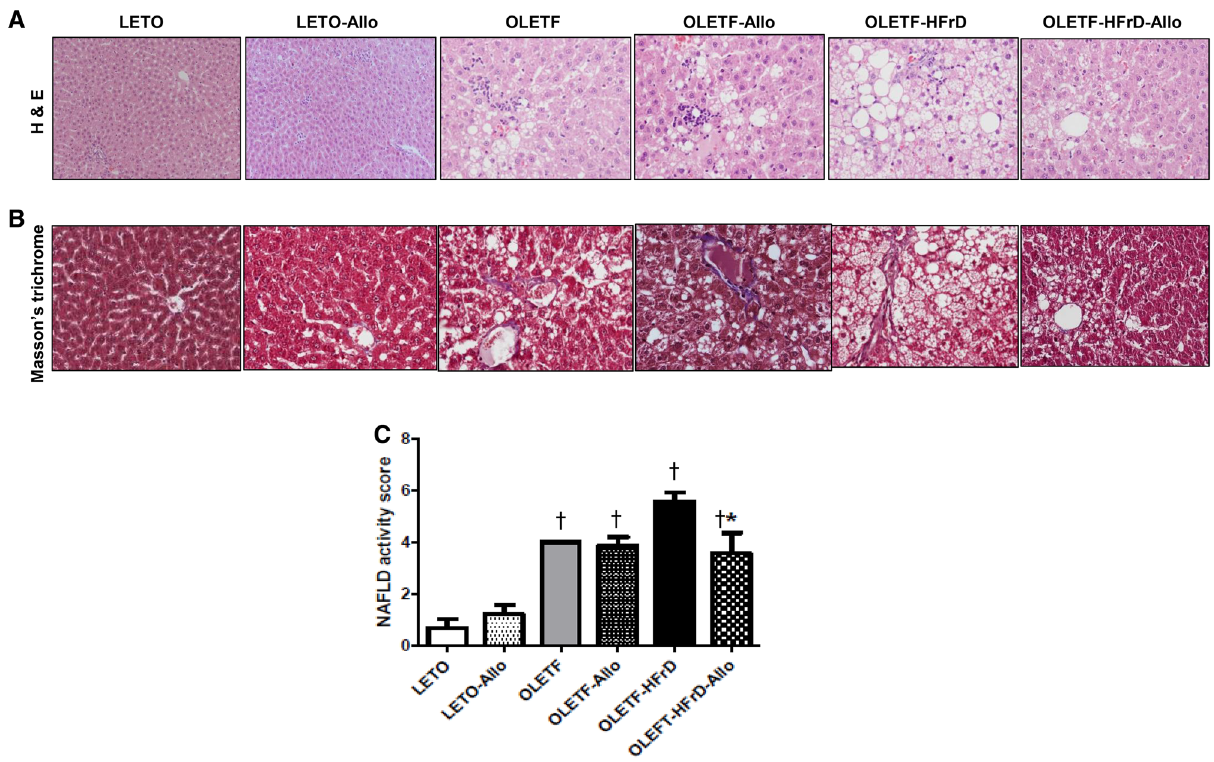
Figure 2. Liver pathology and NAFLD activity score after 16 weeks of LETO, OLETF, and HFrD-fed OLETF rats with or without allopurinol treatment. Liver morphology was visualized and evaluated using light microscopy (400 × magnification) on tissue sections subjected to hematoxylin and eosin (H&E) and Masson’s trichrome stains. ( A ). H&E-stained sections from rats in the OLETF and OLETF-HFrD group showed significant hepatic lipid accumulation compared to LETO group. Hepatic steatosis was decreased in the OLETF- HFrD-Allo group. ( B ). Significant fibrotic changes were not observed in all experimental groups. ( C ). NAFLD activity score was significantly elevated in the OLETF and OLETF-HFrD group compared to LETO group. Also, it was significantly decreased in OLETF-HFrD-Allo group, compared to OLETF-HFrD group. † P < 0.05 versus LETO group. * P < 0.05 versus OLETF-HFrD group. LETO, Long-Evans Tohushima Otsuka; LETO-Allo, LETO rats treated with allopurinol; OLETF, Otsuka Long-Evans Tokushima Fatty rats; OLETF-Allo, OLETF rats treated with allopurinol; OLETF-HFrD, OLETF rats fed with high fructose diet; OLETF-HFrD-Allo rats, OLETF rats fed with high fructose diet which were treated with